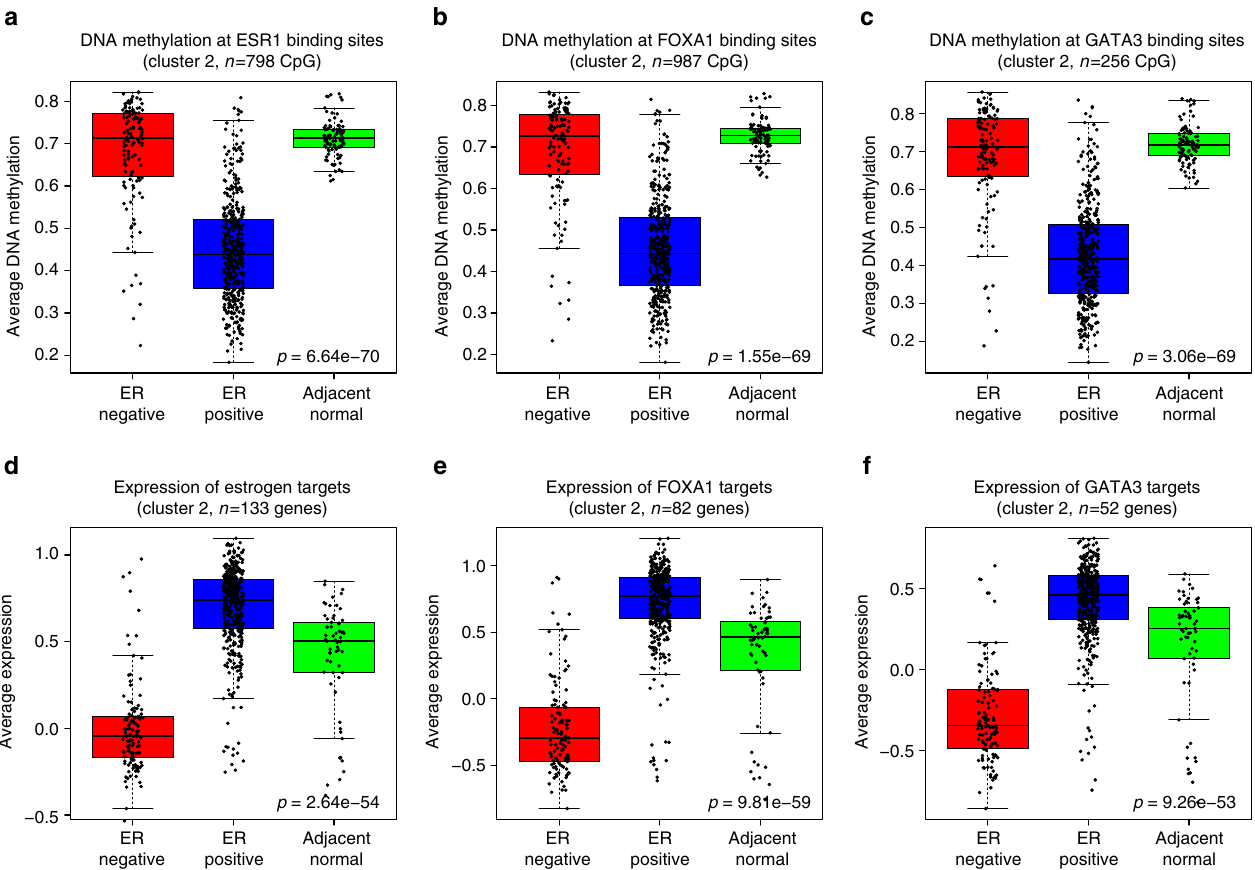
Fig. 5 DNA methylation of ER α , FOXA1 and GATA3 binding regions and expression of their target genes in Cluster 2. a – c Average DNA methylation of CpGs in Cluster 2 and ER α a , FOXA1 b and GATA3 c binding regions de fi ned by ChiP-seq peaks. Boxplots represent the average DNA methylation of these CpGs in ER positive ( blue , n = 418), ER-negative tumors ( red , n = 124) and adjacent normal tissue ( green , n = 97). The average methylation of the Cluster2- CpGs in a TF binding site was signi fi cantly lower in ER positive patients compared to ER-negative and adjacent normal tissue. d – f Average gene expression of TF target genes in Cluster 2. d Estrogen (GRO-seq), e FOXA1 (siRNA) and f GATA3 (siRNA). Boxplots represent the average expression of the TF target genes in ER positive tumors ( blue , n = 406), ER-negative tumors ( red , n = 117) and adjacent normal tissue ( green , n = 61). The average expression was signi fi cantly higher in ER positive tumors compared to ER-negative and adjacent normal tissue. Kruskal – Wallis test p -values are